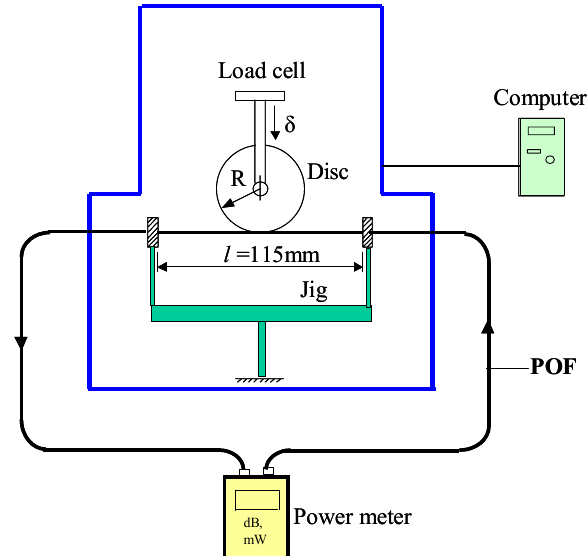
Figure 1. Experimental setup used to measure power loss in grooved POF specimens under combined bending and elongation